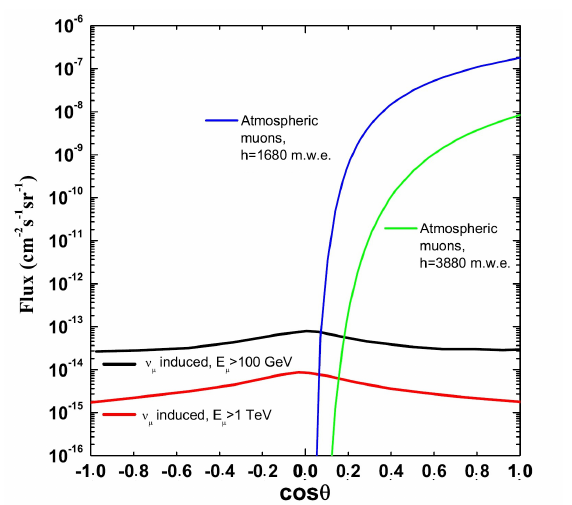
Figure 7. Flux as a function of the cosine of the zenith angle θ of: (i) atmospheric muons for two different depths; (ii) muons induced by CC interactions of atmospheric ν µ , for two different muon energy thresholds E µ . Upgoing (down-going) events have cos θ < 0 ( > 0 )